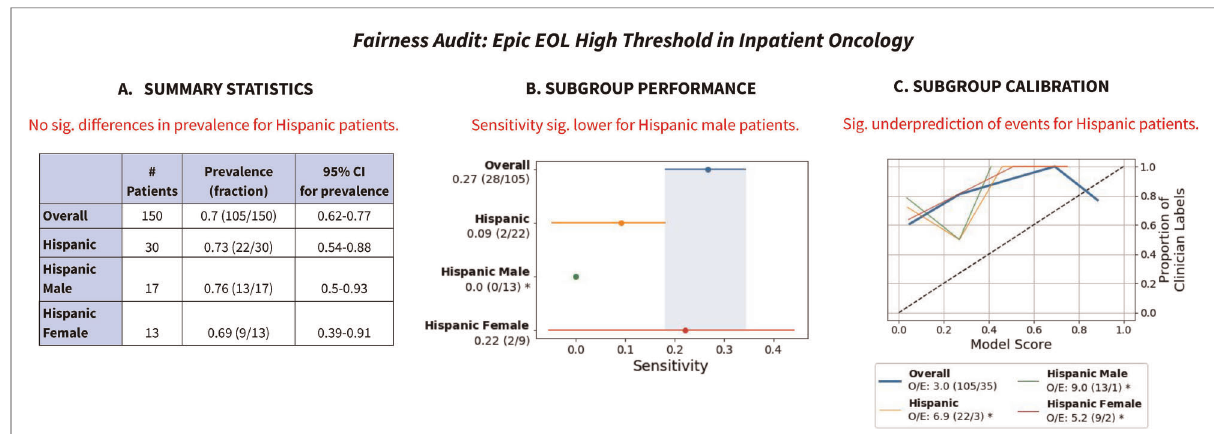
FIGURE 2 Summary of fairness audit fi ndings, for Hispanic patients for the Epic EOL High Threshold in Inpatient Oncology. ( A ) Summary statistics revealed no signi fi cant difference in prevalence for Hispanic patients. ( B ) Subgroup performance revealed decreased sensitivity on Hispanic patients and that it was especially low for Hispanic male patients. ( C ) Subgroup calibration revealed signi fi cantly greater miscalibration for Hispanic patients, including for Hispanic female patients and especially for Hispanic male patients. Note: we refer to Hispanic patients with Race listed as Other as Hispanic patients. “ Sig. ” stands for “ statistically signi fi cant ”